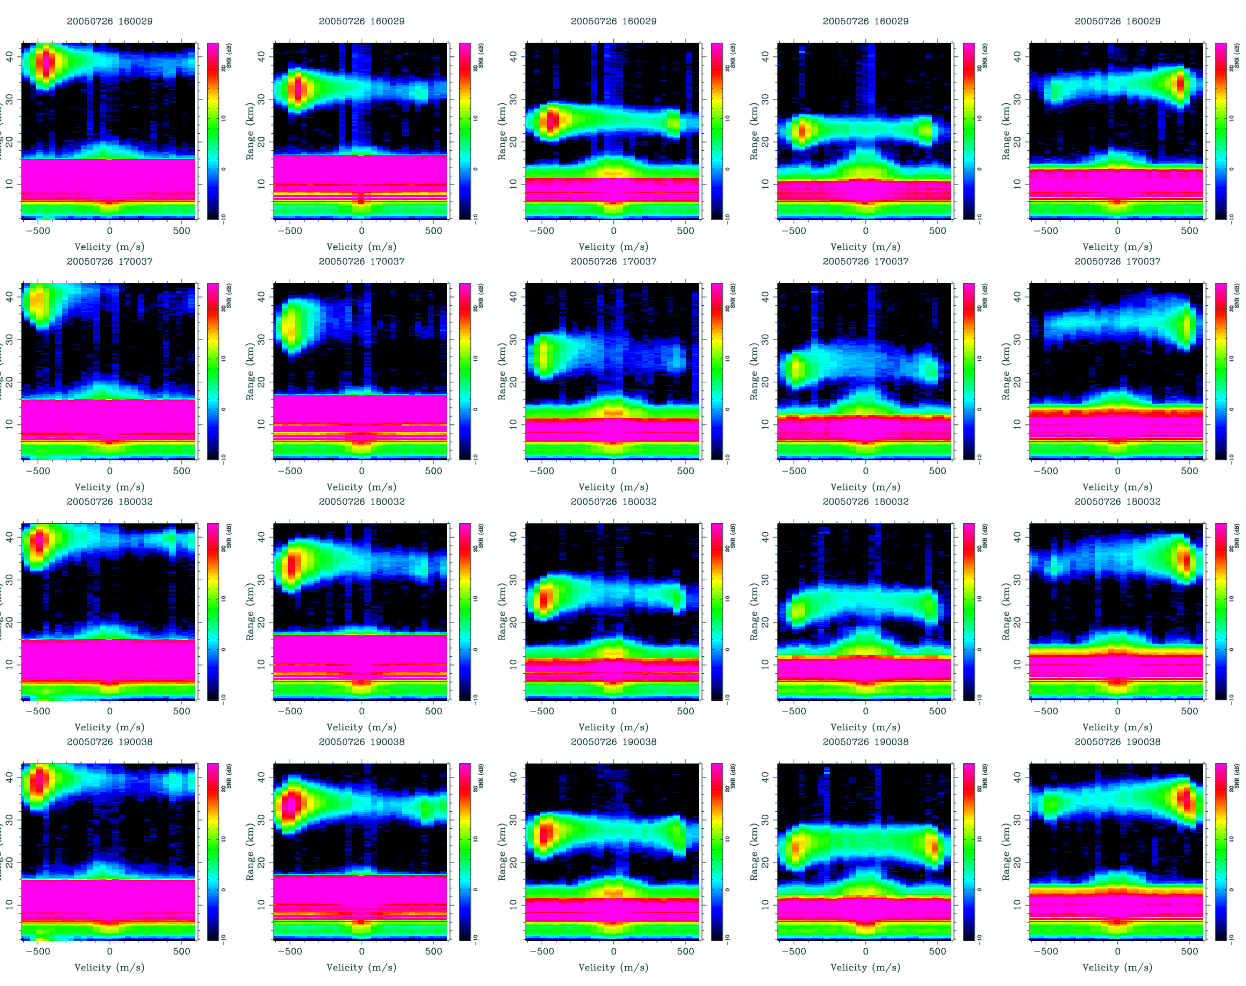
Fig. 5. Spectrograms from the AMISR prototype at Jicamarca. Different rows represent different local times, i.e. 11:00, 12:00, 13:00, 14:00. Different columns represent different zenith angles, i.e. − 32 ◦ , − 24 ◦ , − 12 ◦ , 0 ◦ , 24 ◦ east of